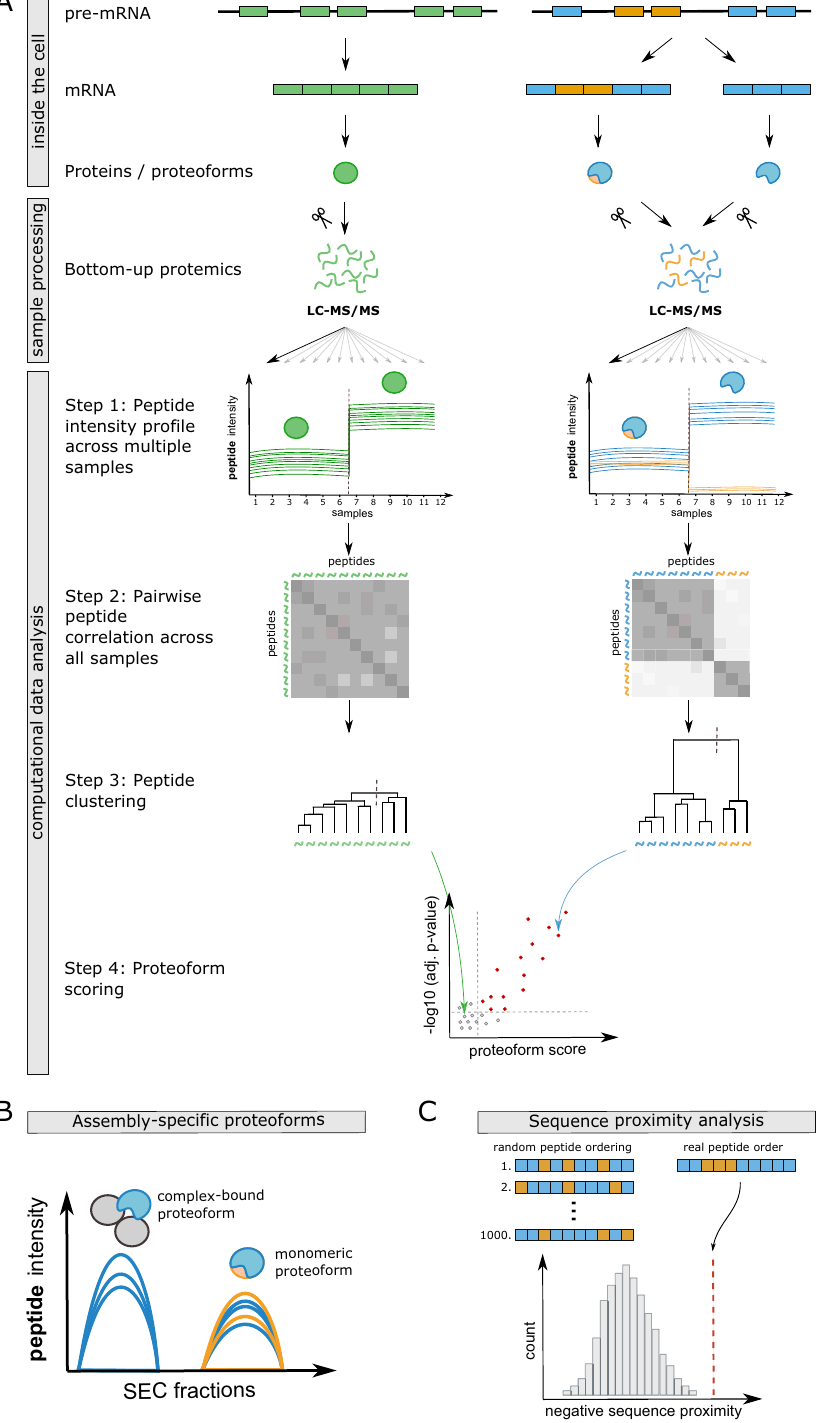
groups differed by 50% of the protein ’ s peptides (Fig. 2C right panel). The observed results are in line with expectations derived from the design of either tool. PeCorA is particularly sensitive in detecting single outlier peptides, whereas COPF is particularly powerful in detecting proteoforms that differ by multiple peptides. Looking at the assignment of peptides to proteoforms, it is apparent that PeCorA can successfully determine single proteoform peptides (orange color in Fig. 2C left